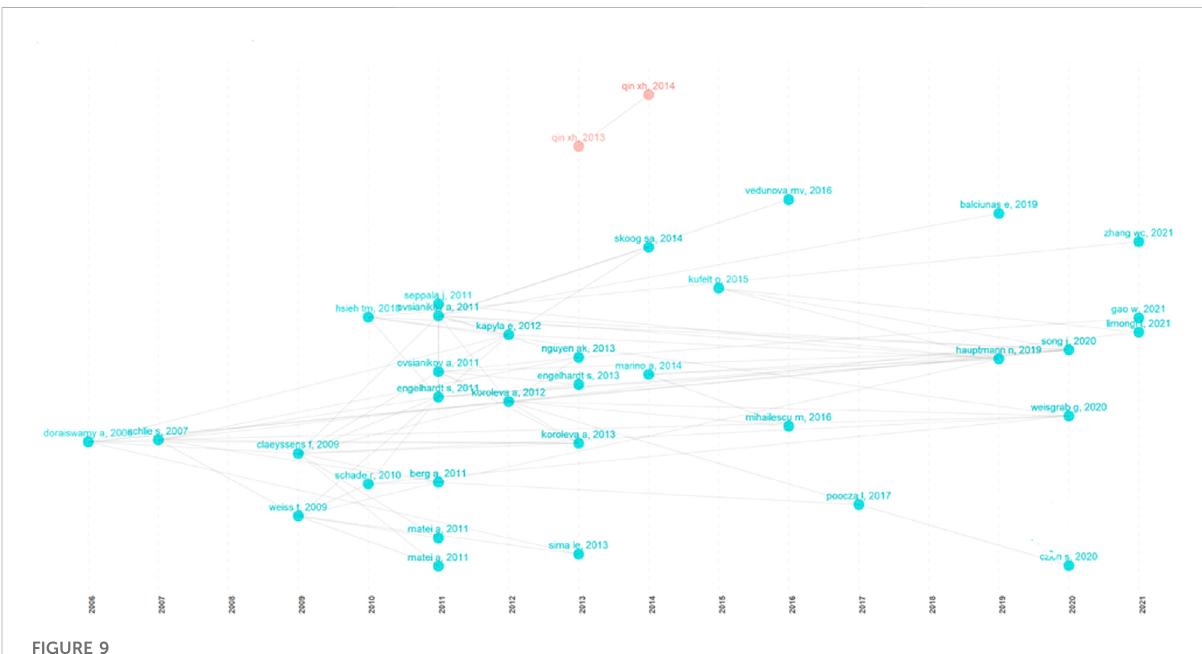
FIGURE 9 Landmark articles related to applications of TPP in biomedical fi